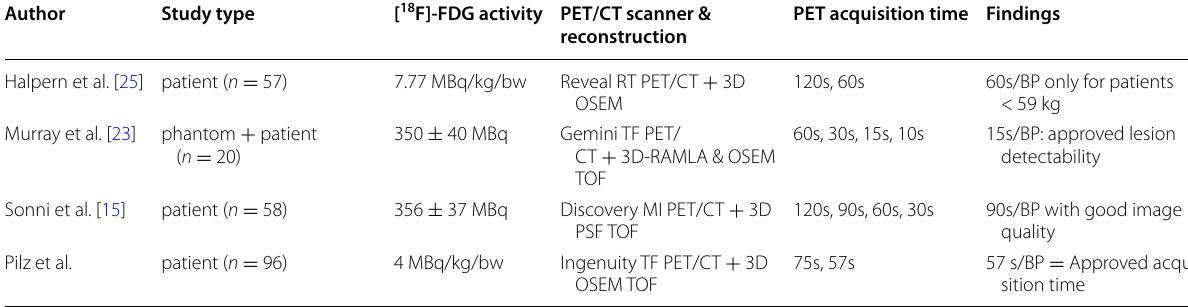
Table 6 Comparison of studies focusing on PET acquisition